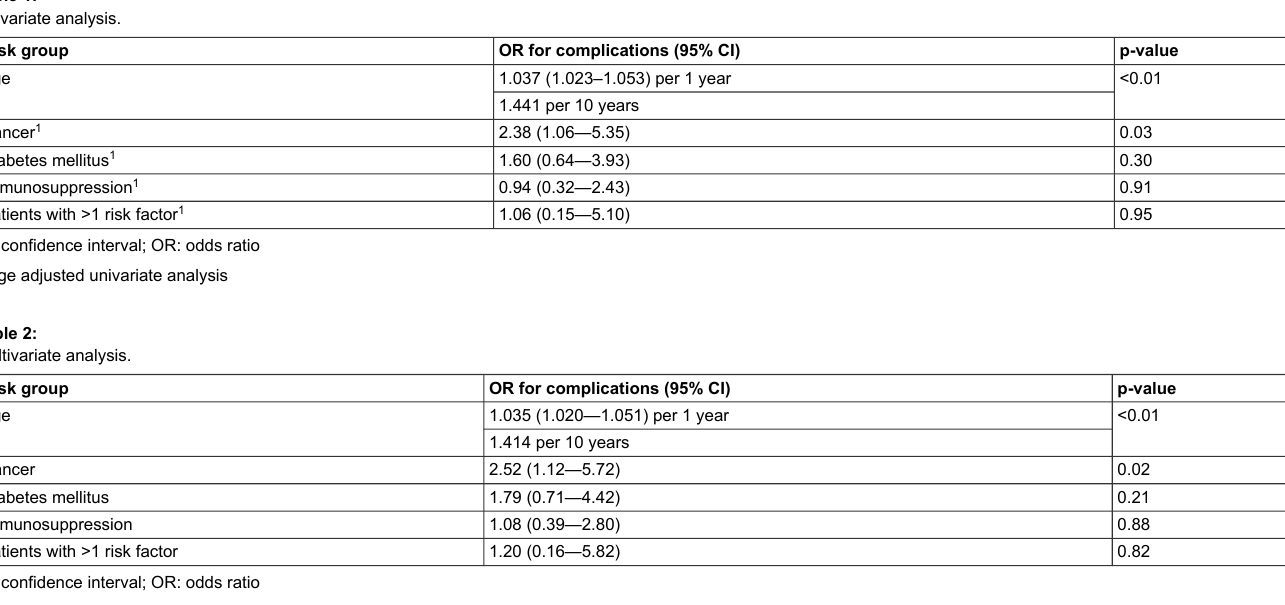
Figure 3: Complication rate per age group (n =